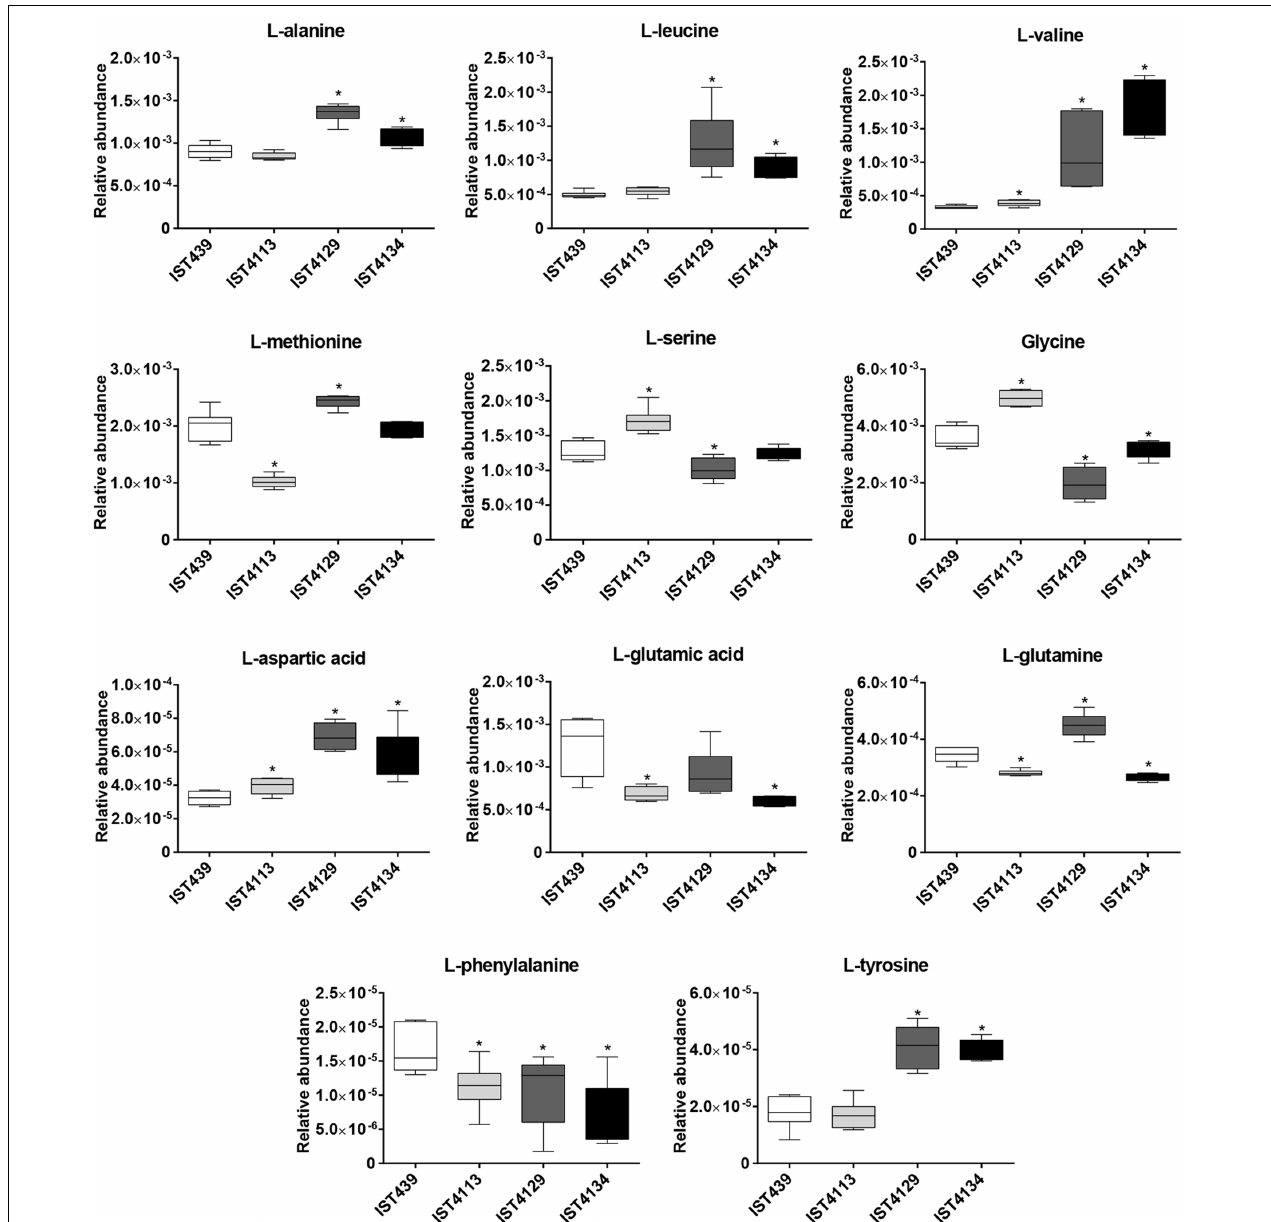
FIGURE 3 | Relative abundance of the amino acids detected through the comparative analysis of the endometabolomes of four B. cenocepacia sequential clonal variants retrieved from a CF patient chronically infected for 3.5 years. Each plot shows the variation of the relative abundance of a representative bin in all the spectra for each metabolite and B. cenocepacia isolate. Median values are represented by the line in the middle of the box with the ends showing the 25th and 75th percentiles. Upper and lower ends of the lines represent the maximum and minimum values respectively. ∗ P < 0.05 when each late B. cenocepacia isolate was compared to the first isolate,